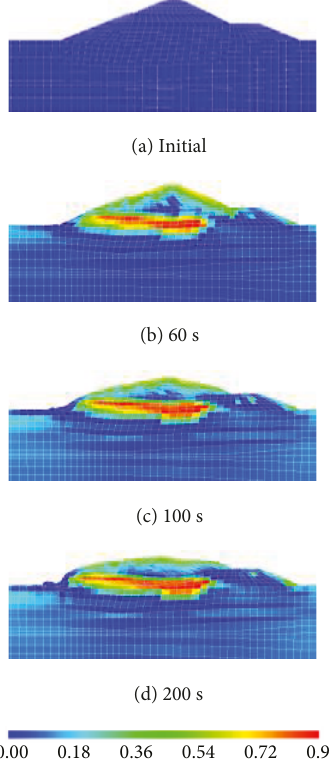
Figure 26: Distribution of accumulative deviatoric plastic strain